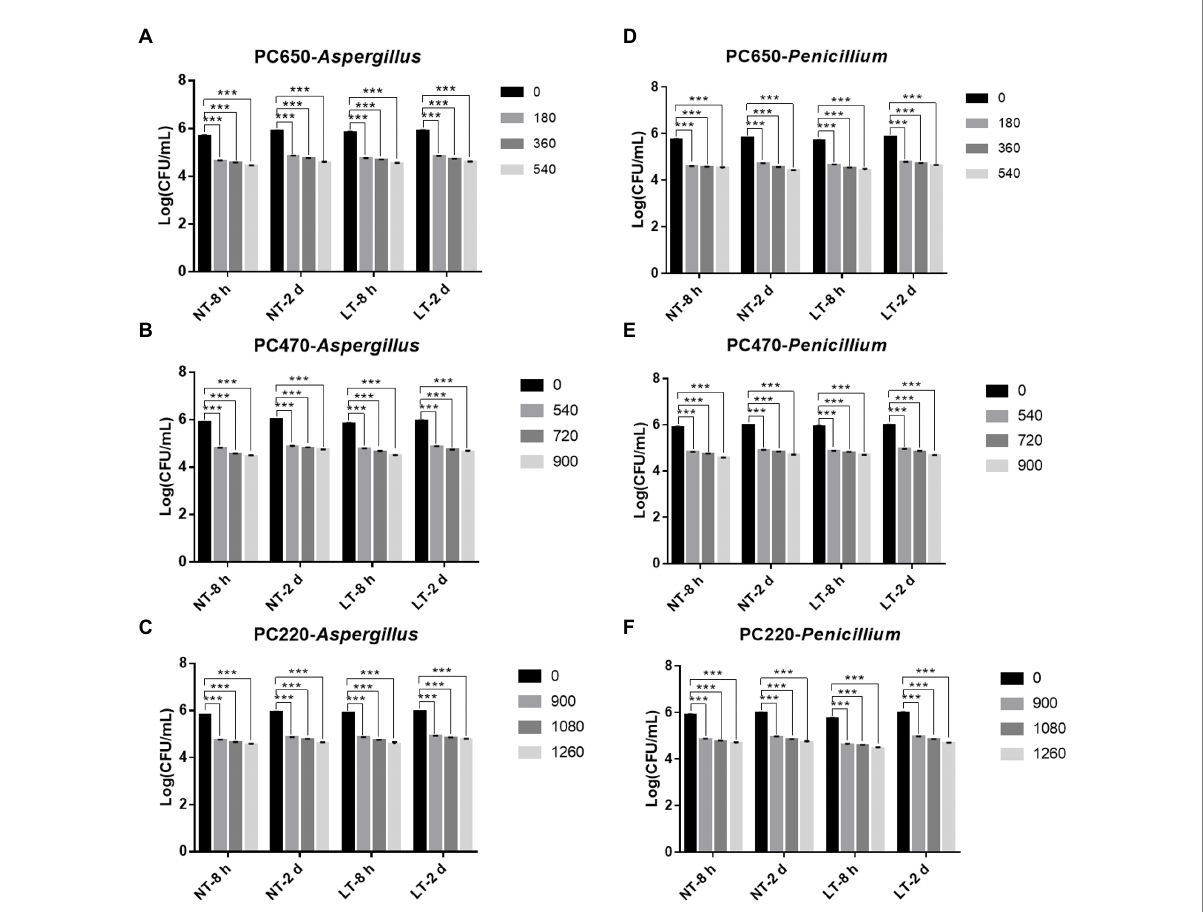
FIGURE 3 IPL sterilization efficiency on biofilm of Aspergillus niger and Penicillium glaucum under different capacitances in polycarbonate membrane model. (A–C) IPL sterilization efficiency on biofilm of A. niger . (D–F) IPL sterilization efficiency on biofilm of P. glaucum . (650 μ F: 0.0407 J*cm − 2 , 470 μ F: 0.0319 J*cm − 2 , and 220 μ F: 0.0150 J*cm − 2 ). The asterisks denote statistical significance as determined by One-way ANOVA test (*** p < 0.001, **0.001 < p < 0.01, *0.01 < p < 0.05). Error bars indicate SD from three independent